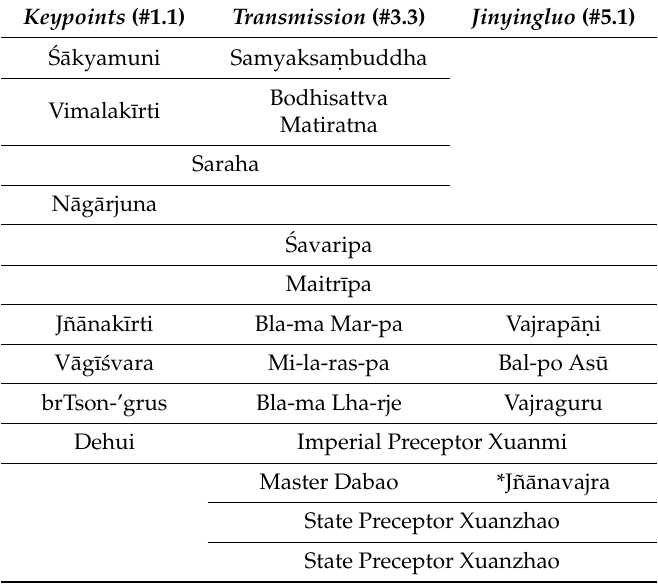
Table 1. Mah¯amudr¯a transmissions in